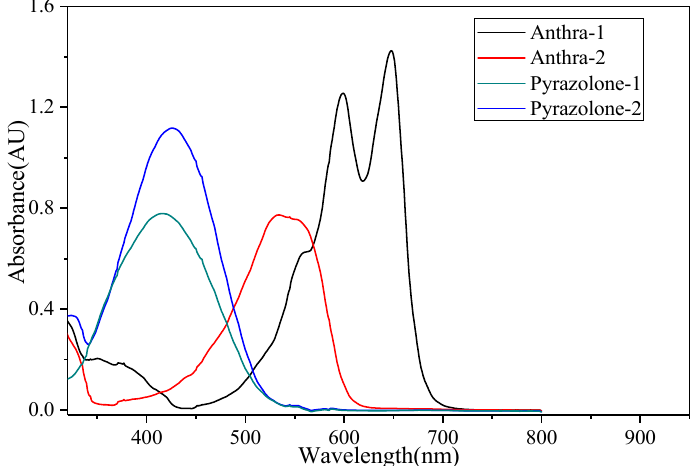
Figure 3. UV-visible absorption spectra of four dyes.